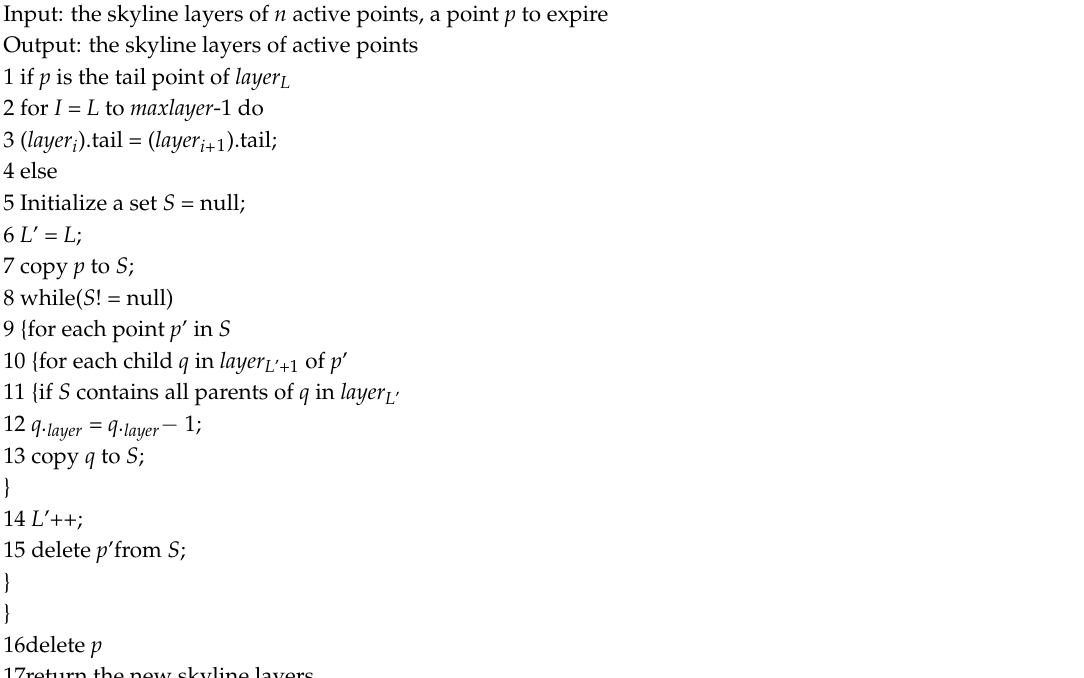
Algorithm 3. Update Skyline Layers for Point Expiring